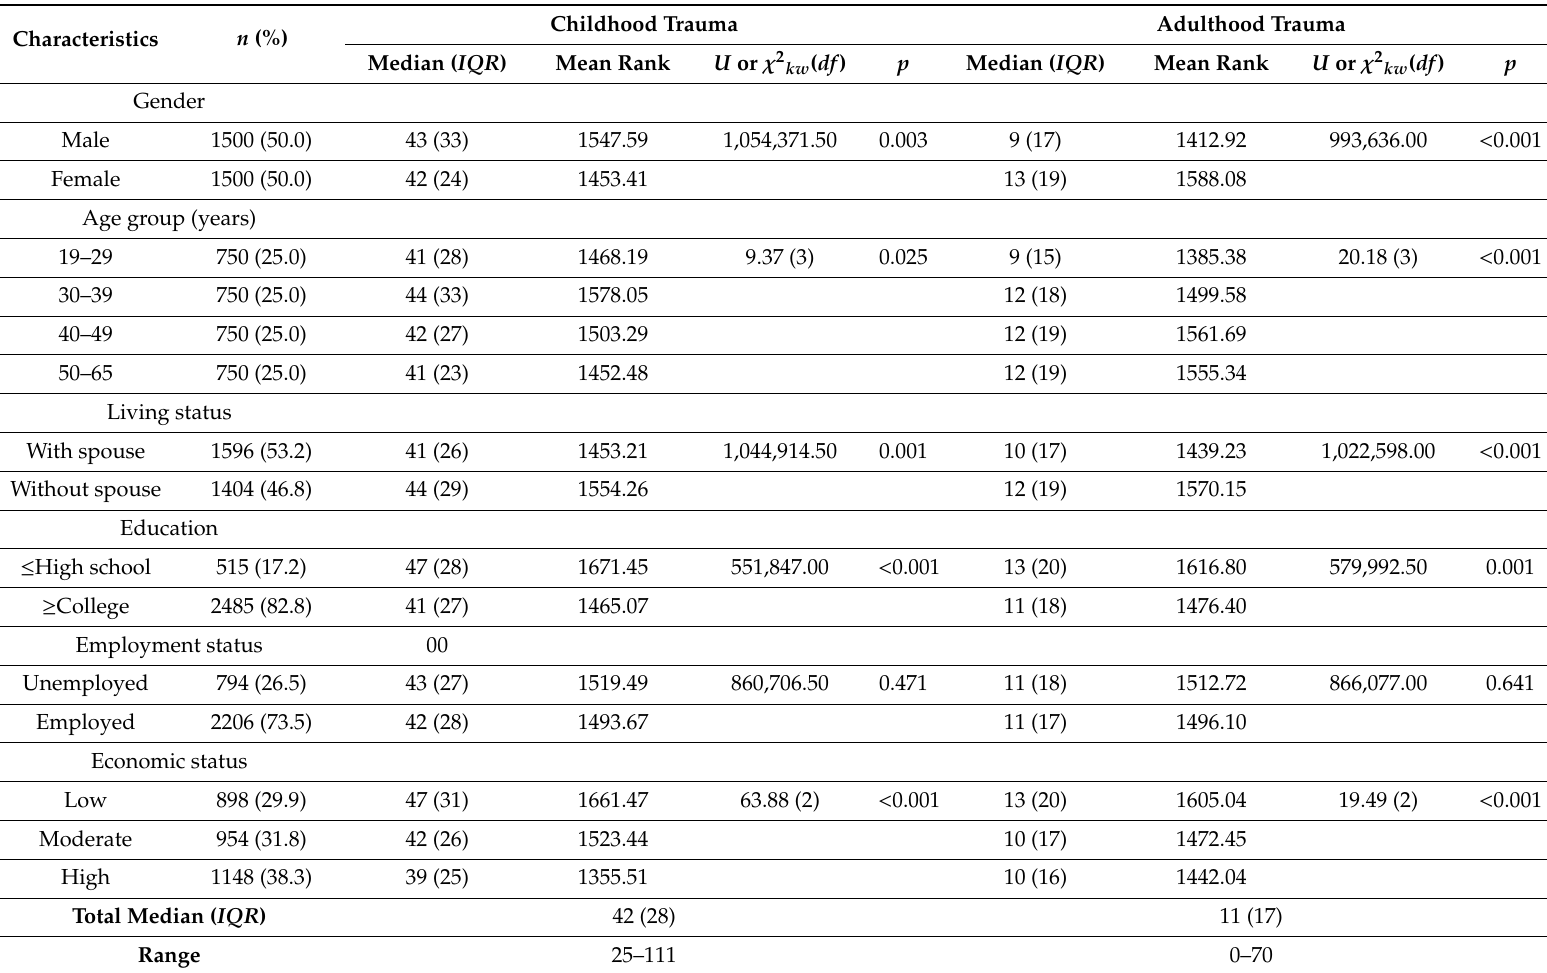
Table 1. Di ff erences in trauma-related variables by sociodemographic characteristics ( N =